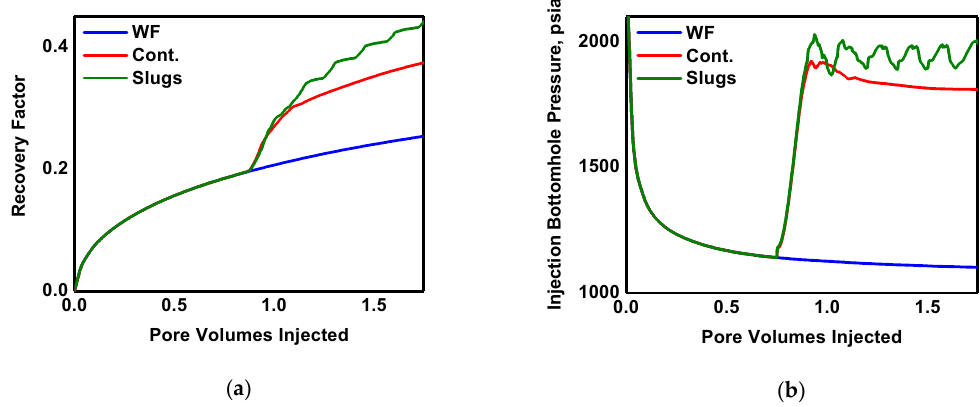
Figure 3. Oil recovery factor ( a ) and injection bottom hole pressure ( b ) as a function of pore volumes injected for the test case using waterflooding (WF), continuous polymer flooding (Cont.), and the compositionally-tuned slug-based process (Slugs).